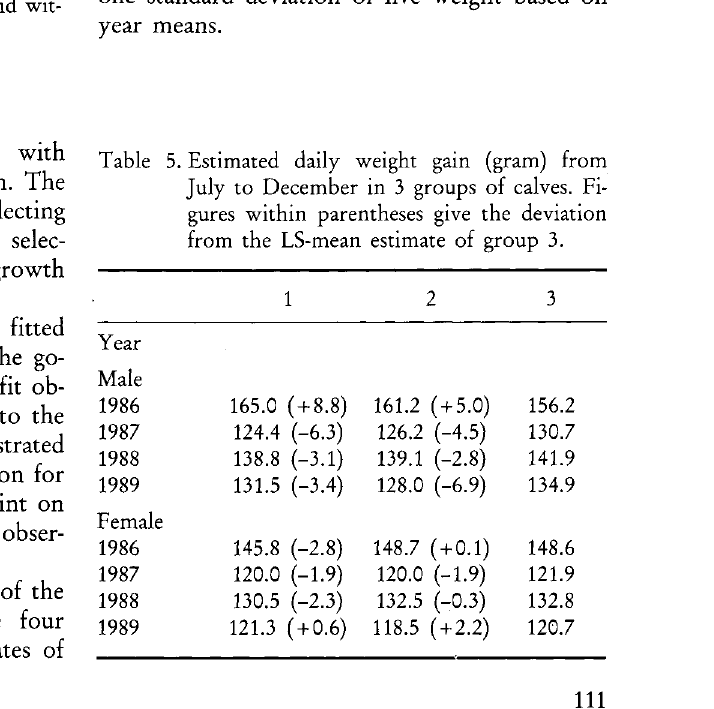
standard deviations and coefficients of variation within and between years, are presented in Ta ble 8. Fig. 1 is based on data presented in Table 8, with Model 2 fitted to the weights for each of the sexes. As shown, body weight increased rapidly during about the first 20 days; thereaf ter the growth rate decreased gradually and the body weight remained relatively constant du ring the last month and a half. At the end of the period a small weight loss was observed for the male cohort. The two outer lines represent ± one residual standard deviation in live weight (within year) and the two inner lines around the mean weight curve represents ± one standard deviation of live weight based on year means.